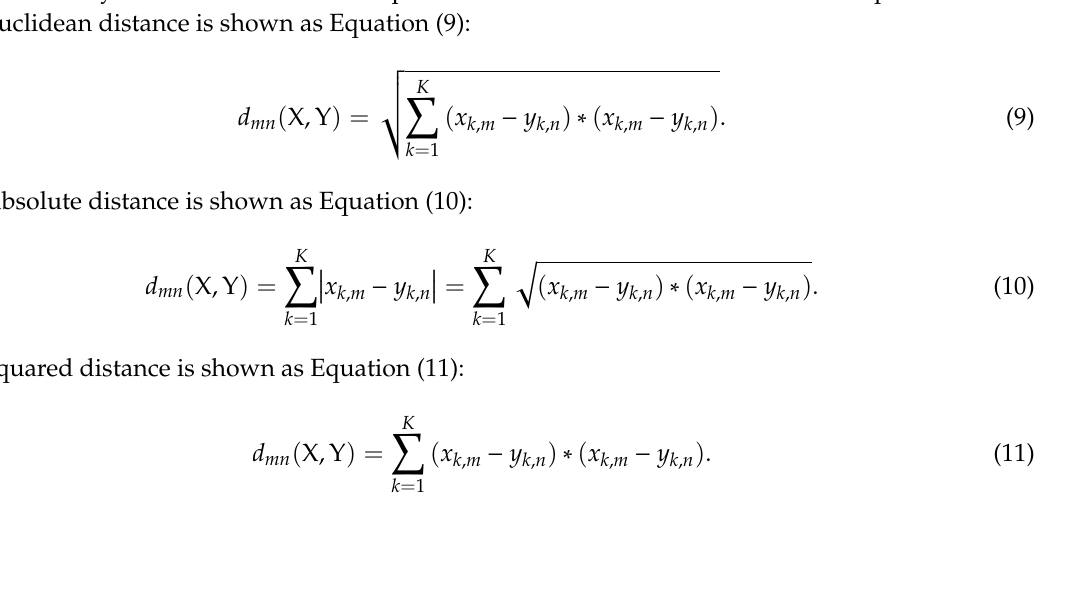
Algorithm 2: Pseudo-code of the algorithm for forming principle components. DTW ( A , G ) { // where the vectors A = (a gyroscope with n and m data points,